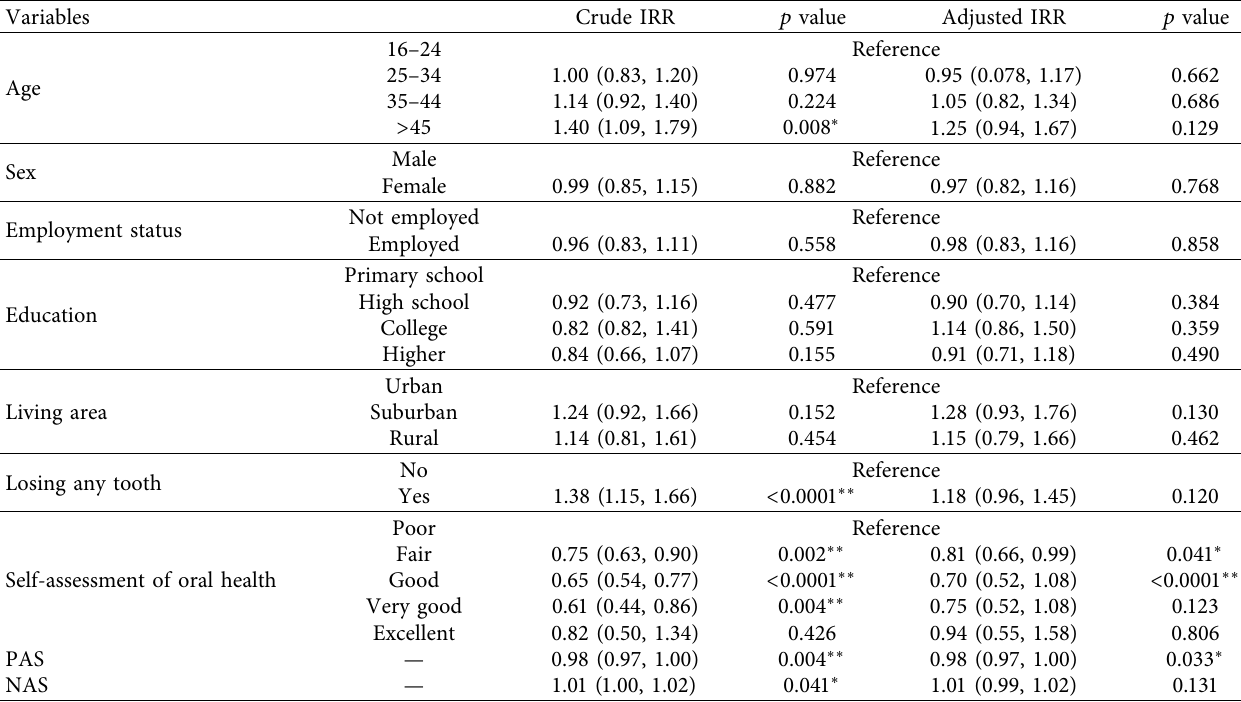
Table 3: The association between OHIP 14 score, PAS, NAS, and demographic characteristics.